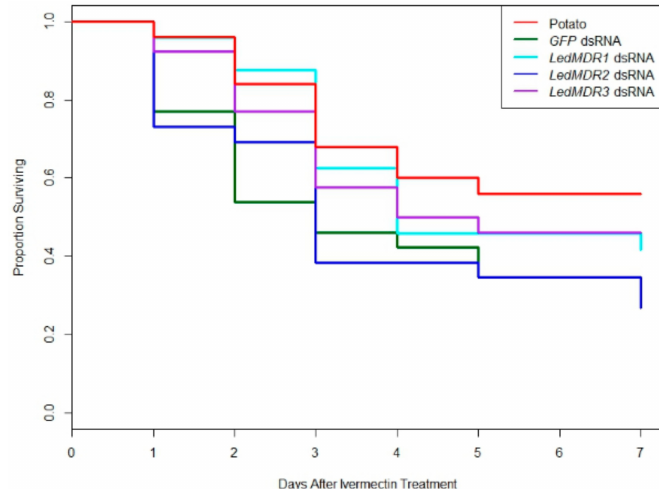
Figure 3. Proportion of adult L. decemlineata surviving in di ff erent dsRNA feeding treatments each day after consuming ivermectin. L. decemlineata adults were fed with the indicated treatment for three days before being given a 1 µ L dose of 20 ppm ivermectin. No significant di ff erences were observed between treatments (log-rank test, χ 2 (4, 24) = 7.5, p = 0.1).